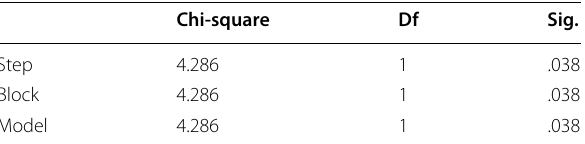
Table A: Omnibus tests of model coefficients on innovation culture and MAP